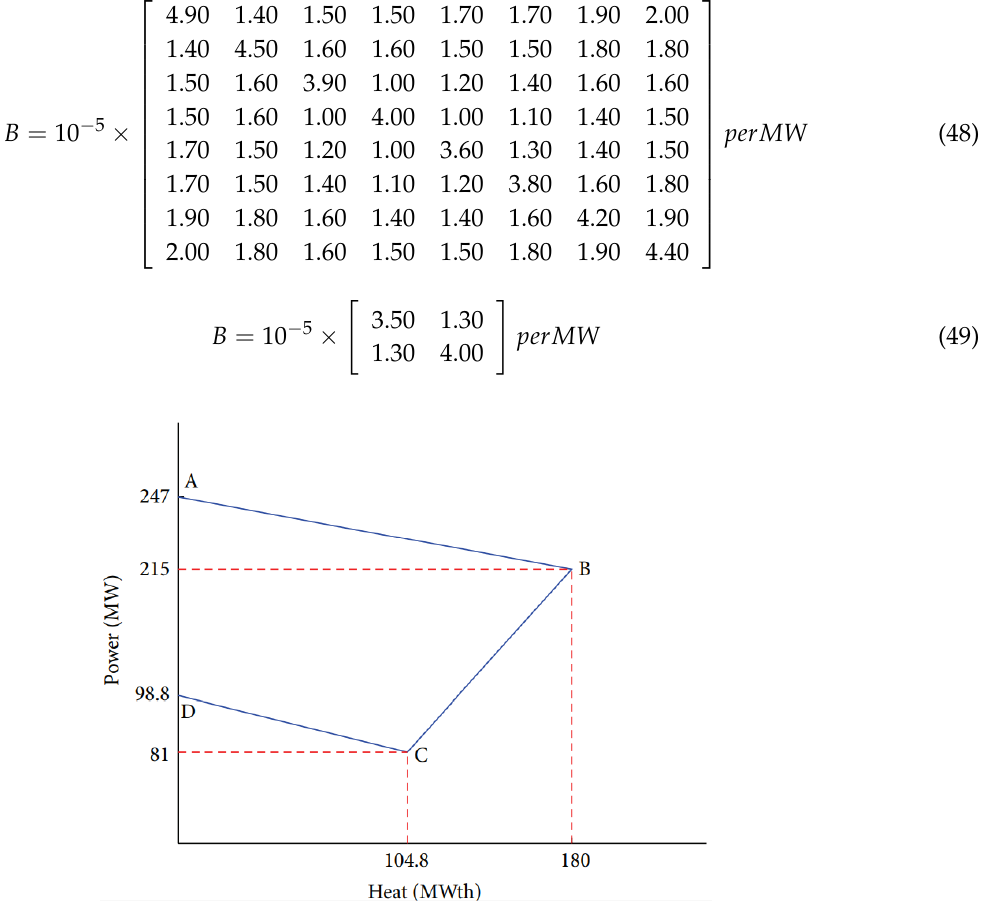
Figure 5. Power heat feasible operating region for CHP Unit 1.